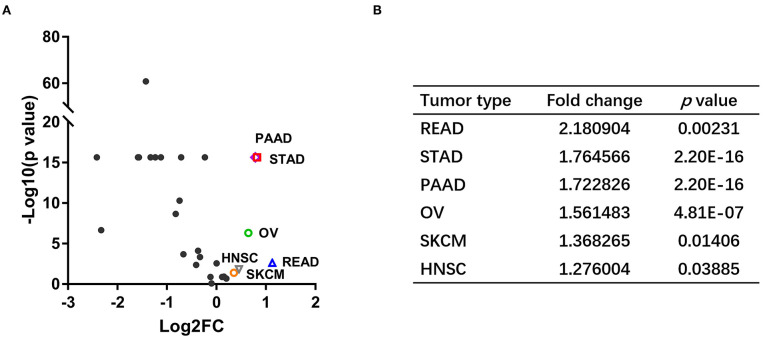
NOS3 is differentially expressed in various tumors and their corresponding normal tissues. (A) Scatter plot of log2 FC and minus log10(p-value) across different cancers. The horizontal line on the Y-axis represents a p-value of 0.05. Points above the horizontal line have statistical significance. The vertical line on the X-axis represents log2 FC was−1 or 1, respectively. (B) The log2 FC and p-value in the six tumor types, which expressed higher NOS3 mRNA level.